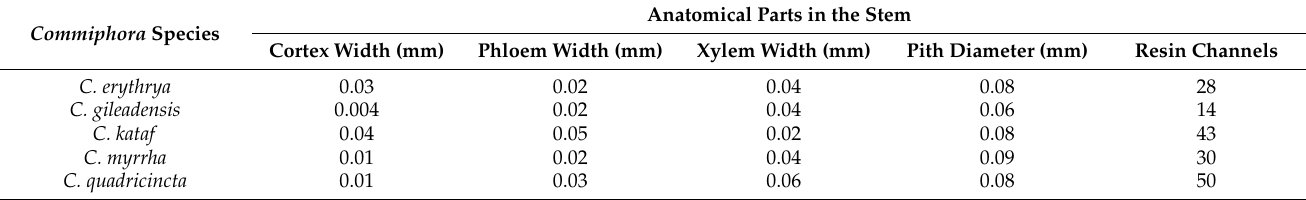
Figure 9. Transverse sections in stems of: ( A ) C. erythraea , ( B ) C. gileadensis , ( C ) C. kataf , ( D ) C. myrrha , and ( E ) C. quadricincta; ep: epidermis, pe: periderm (cork + cork cambium), co: cortex (collenchyma), Table 3. Quantitative anatomical characters of stem in Commiphora sp.